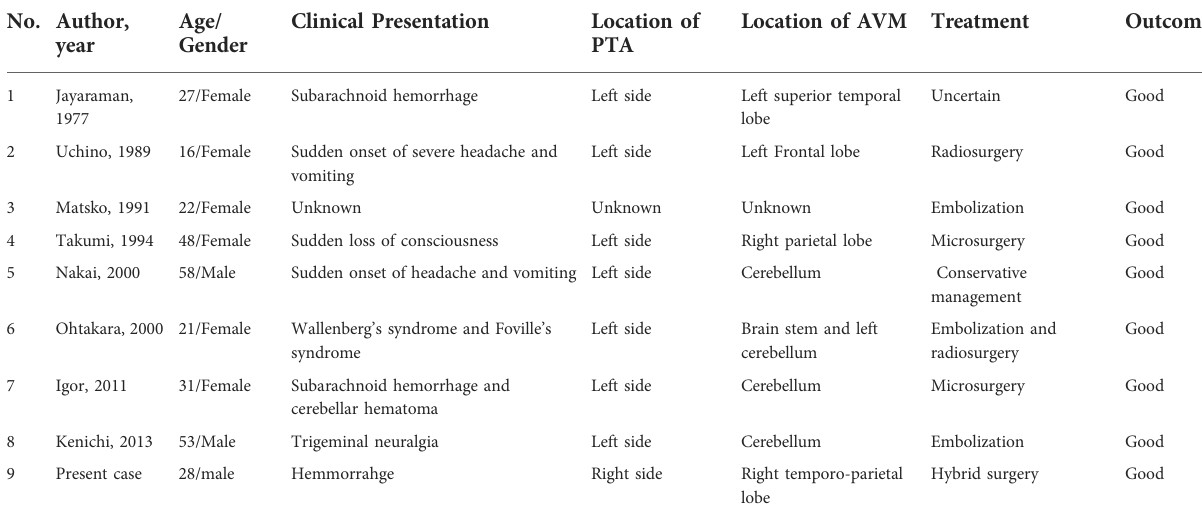
TABLE 1 Summary of AVM associated with